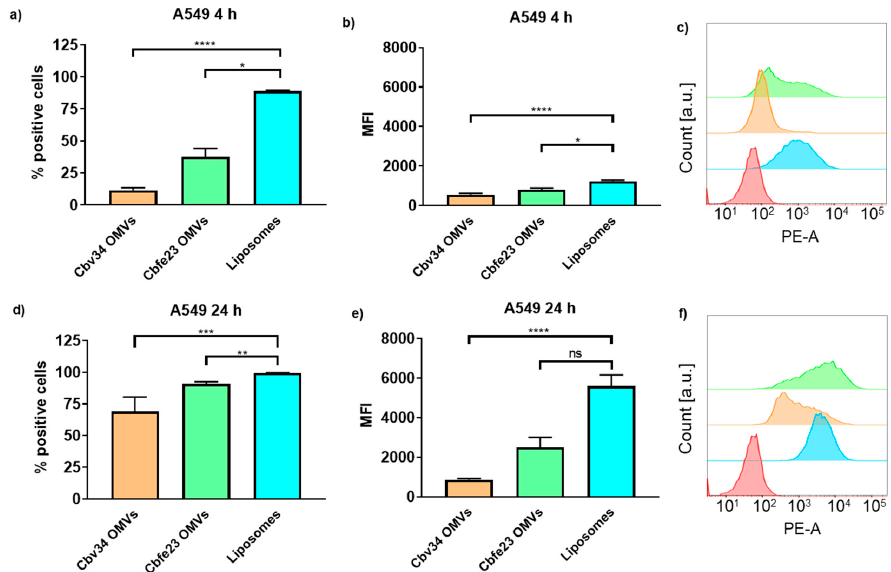
Figure 6. Interaction and uptake of OMVs and liposomes after incubation with A549 cells. The percentage of positive cells (which interacted with DiI-labelled OMVs) after ( a ) 4 h and ( d ) 24 h of incubation. The MFI after ( b ) 4 h and ( e ) 24 h of incubation. Representative histograms of Cbfe23 OMVs (green), Cbv34 OMVs (orange), liposomes (blue) and untreated control (red) after ( c ) 4 h and ( f ) 24 h of incubation. Mean ± SEM, n = 3. * p < 0.05, ** p < 0.005, *** p < 0.0005 and **** p < 0.0001.